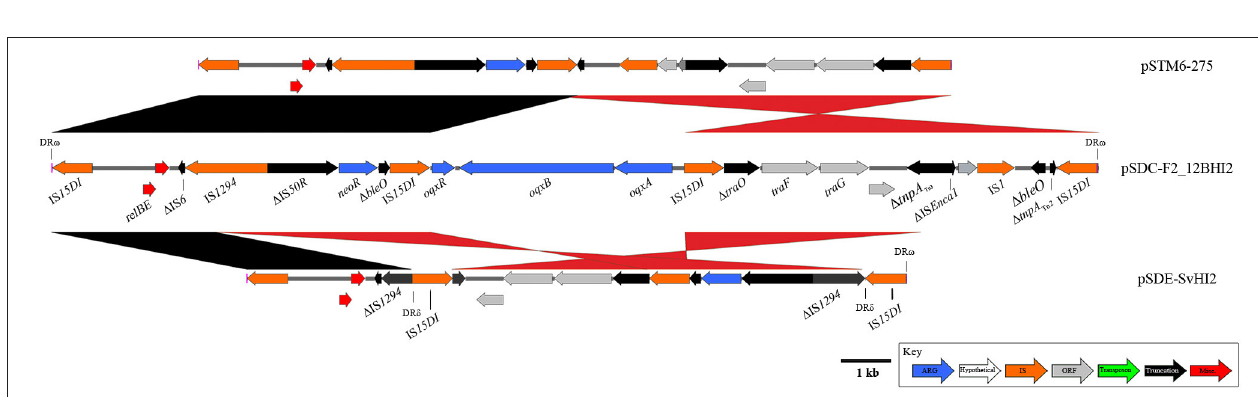
between 1 intI1 and sul3 . A separate inversion event has then occurred between the IS 26 elements nearest to rop , re-inverting this sequence to match the original